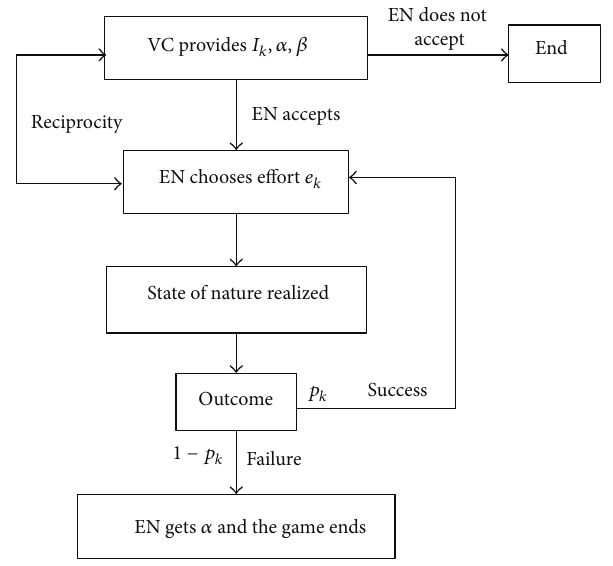
Figure 1: The time